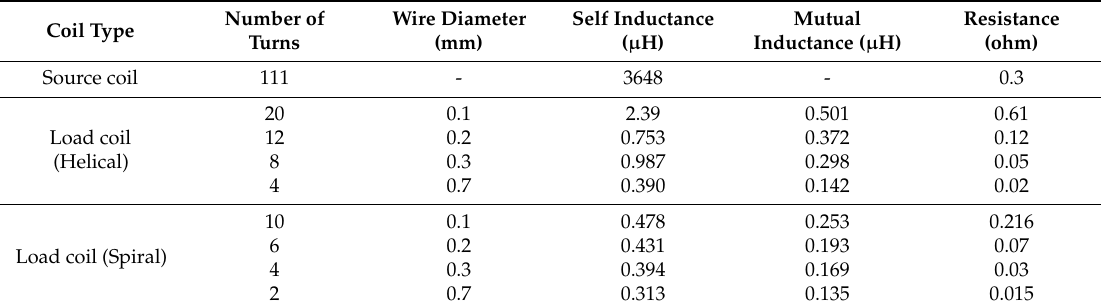
Figure 7. Photographs of the experimental setup ( a ) including source coil, load coil (helical), and the test vehicle floating on water; and ( b ) the load coil with a helical structure. Table 1. Electric parameters of the WPT source coil and load coils.